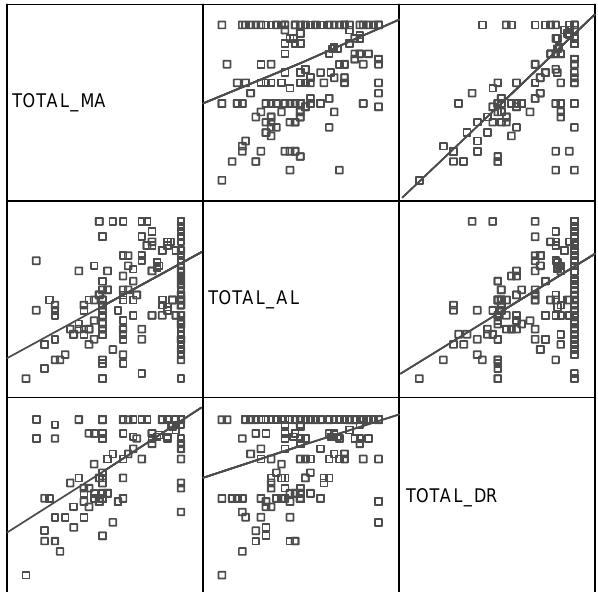
Figura 1 . Gráfico das correlações entre atitudes frente ao uso